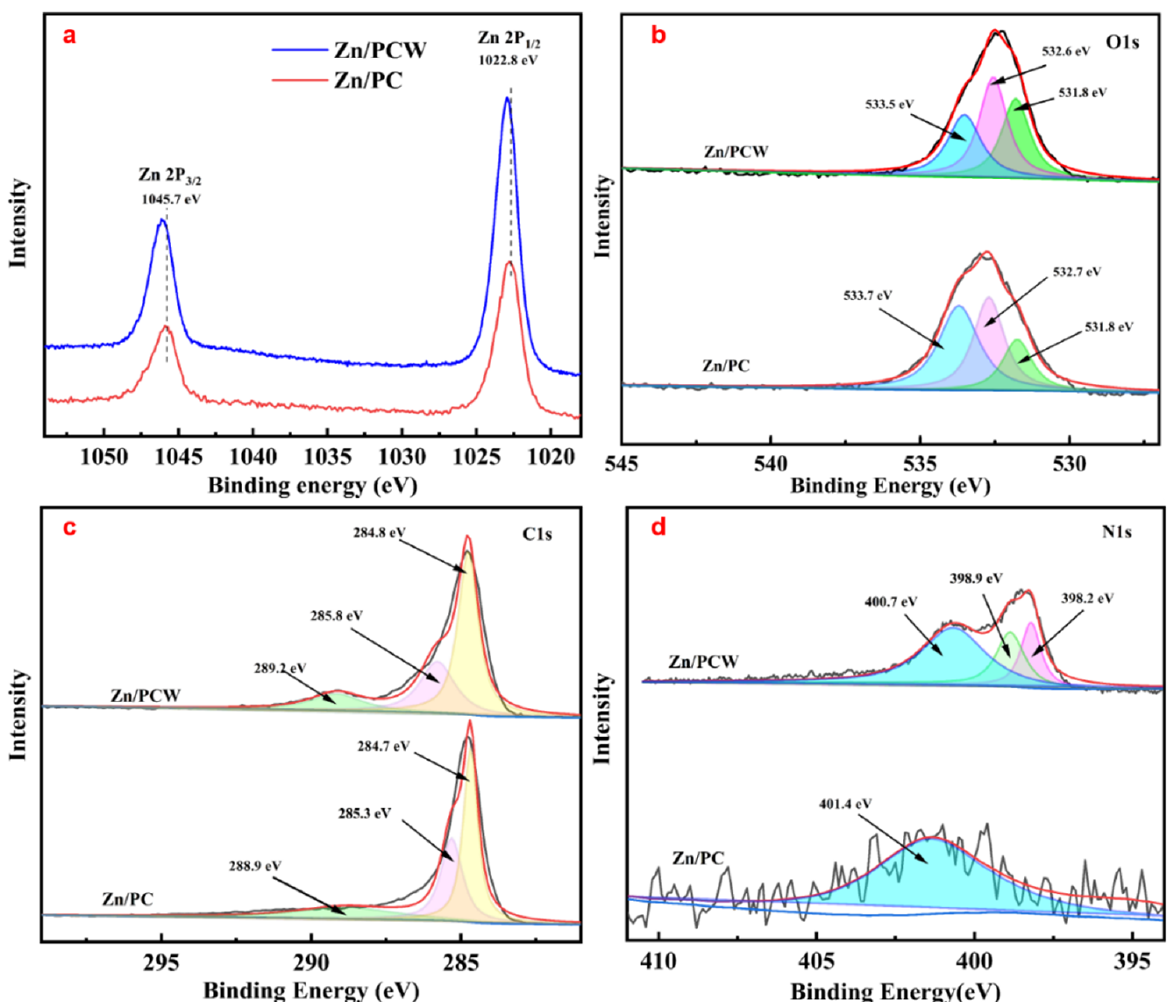
Figure 4. XPS spectra of Zn 2p of Zn/PC and Zn/PCW ( a ) and ( b ) N1s,( c ) C 1s, and ( d ) O1s of PCW.